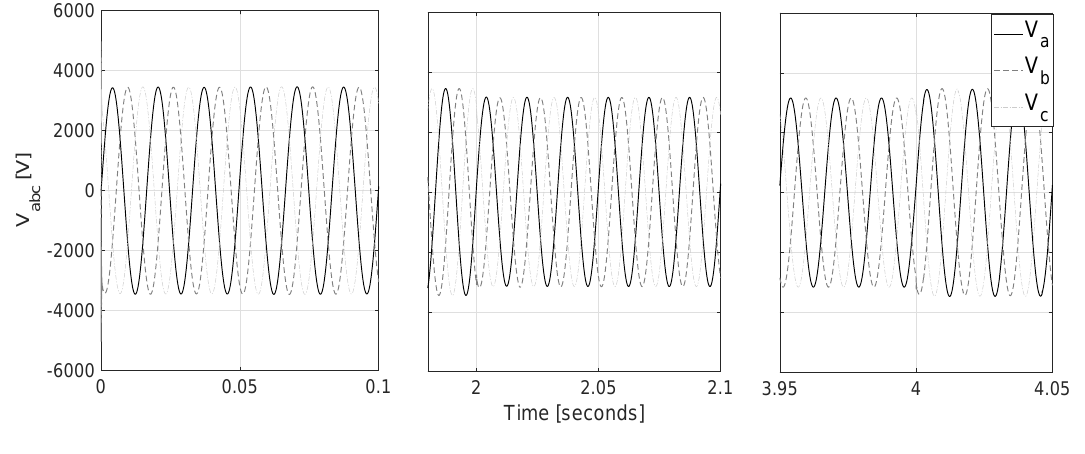
Figure 14. Simulation of voltages v abc during Test 2, with AHN control.